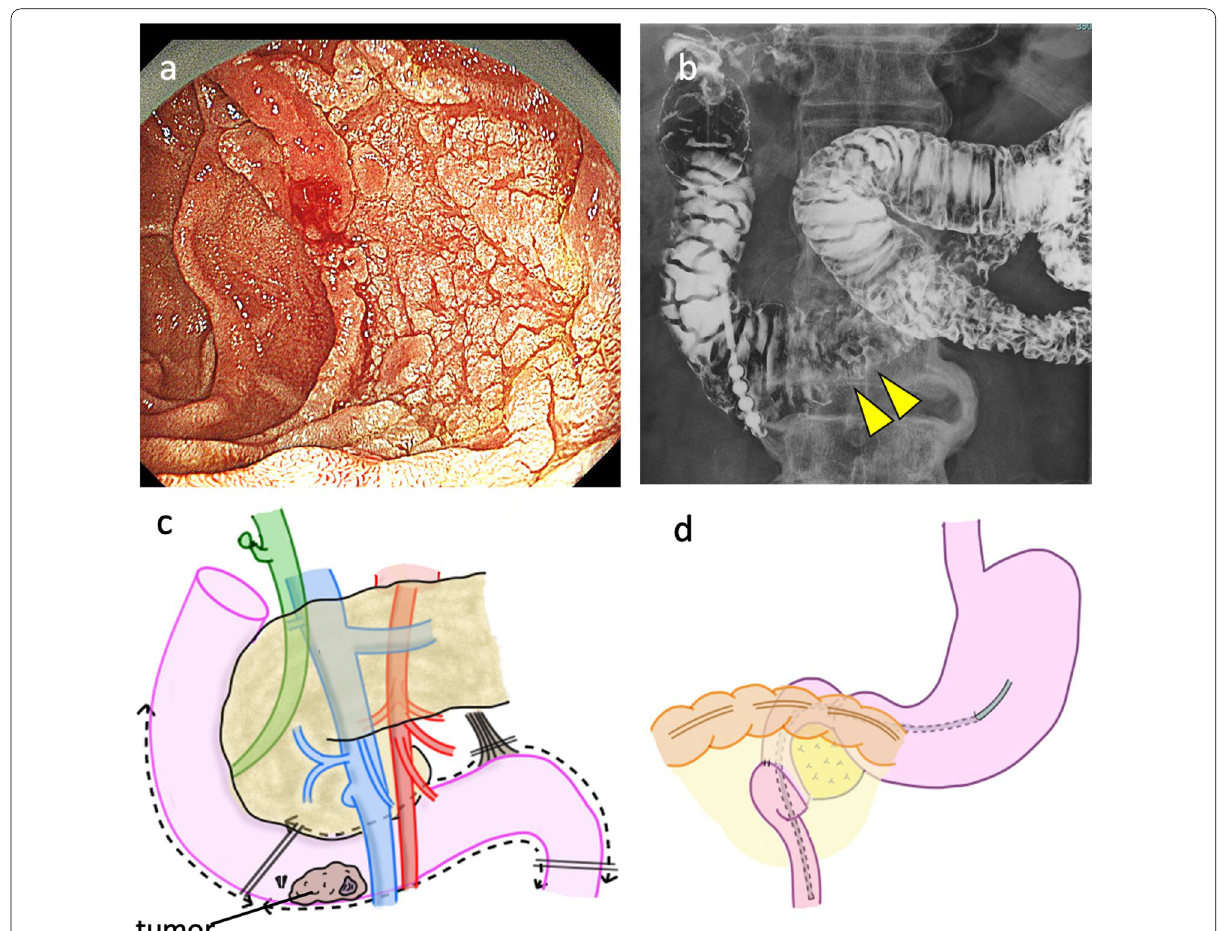
Fig. 4 a Upper gastrointestinal endoscopy revealed a semi-circumferential 0–Is revealed a tumor in the horizontal duodenum. c , d A diagram of surgical procedures is